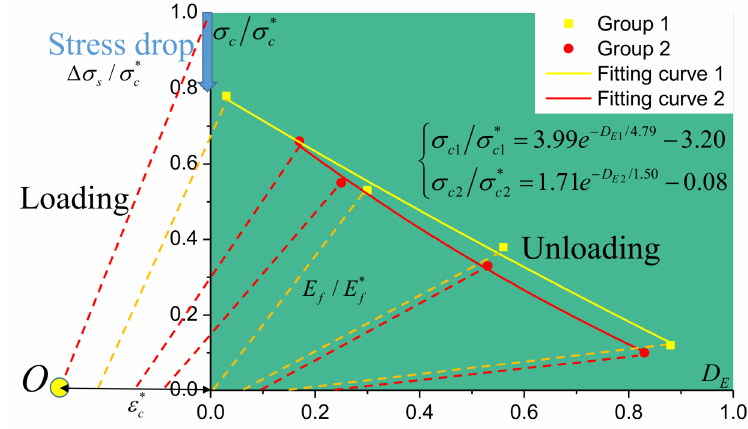
Figure 14. Structural modulus degradation of the test